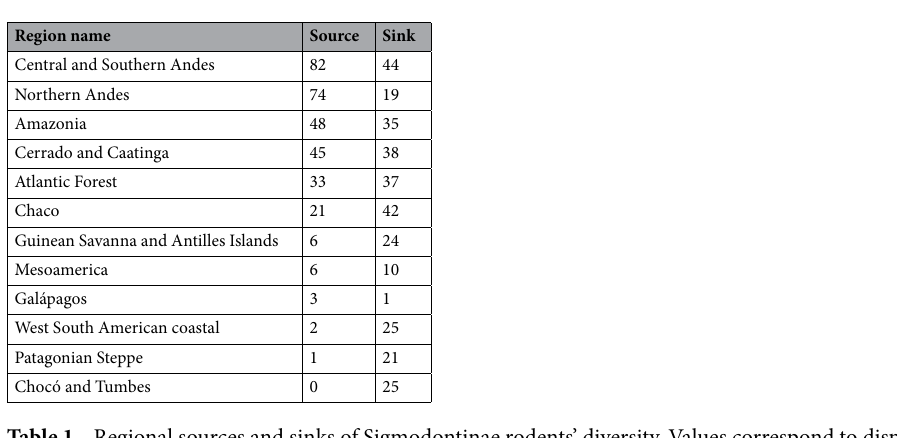
Table 1. Regional sources and sinks of Sigmodontinae rodents’ diversity. Values correspond to dispersal events counted from the biogeographic